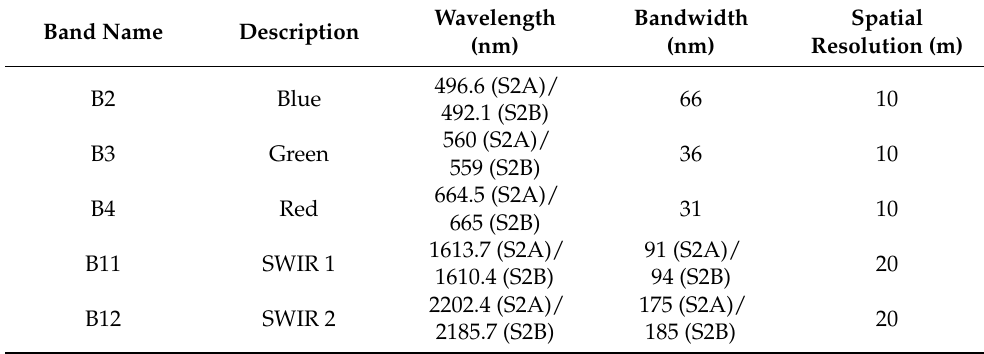
Table 3. Description of Sentinel-2